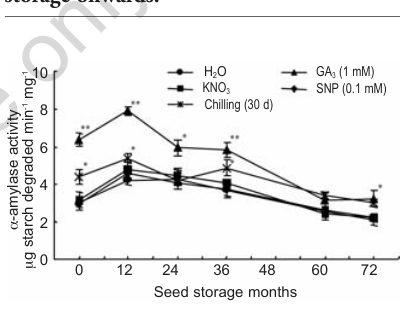
Figure 4. Effect of different seed pre-treat- ments on (cid:0) α -amylase activity of differen- tially stored seeds of H. niger. Data are average of 3 measurements each ± s.d.